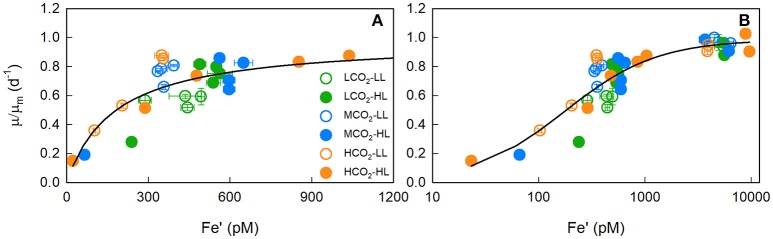
The iron dependency of maximum-normalised growth rates (μ/μm). Panel (A) shows the iron-limitation range (0–1,200 pM) plot on a linear scale while panel (B) shows the full range (0–12 nM) of data plot on a log scale, and includes the data points from Boatman et al. (2017). T. erythraeum IMS101 was cultured at three targeted CO2 concentrations [Low = 180 μatm (green circles), Mid = 380 μatm (blue circles) and High = 720 μatm (orange circles)], two light intensities [LL = 40 μmol photons m−2 s−1 (open circles), HL = 400 μmol photons m−2 s−1 (closed circles)], across a range of Fe′ concentrations (~20–1,010 pM), at optimal temperature (26°C). The solid line is μ/μm modelled by a Michaelis-Menten function (Km of 177 pM with an r2 of 0.803).